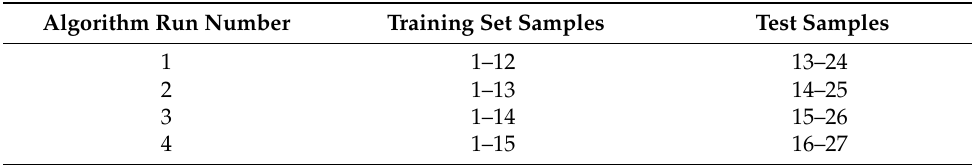
Table 1. Training and test set samples for four algorithms’ runs.